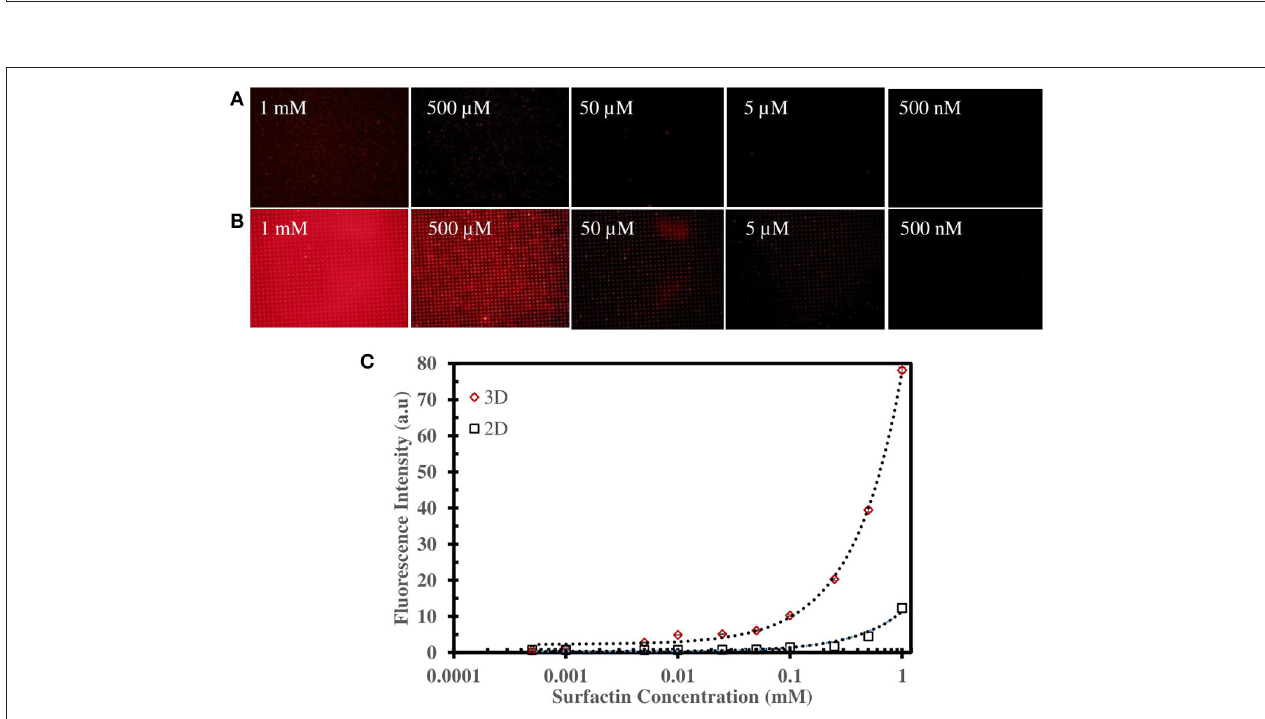
FIGURE 5 | Fluorescence microscopic image of (A) 2D-PDA-PDMS, (B) 3D-PDA-PDMS after exposure to various concentration of surfactin, (C) plot of fluorescence intensity of PDA sensors in 2D and 3D-PDA-PDMS as a function of surfactin concentration in log scale.